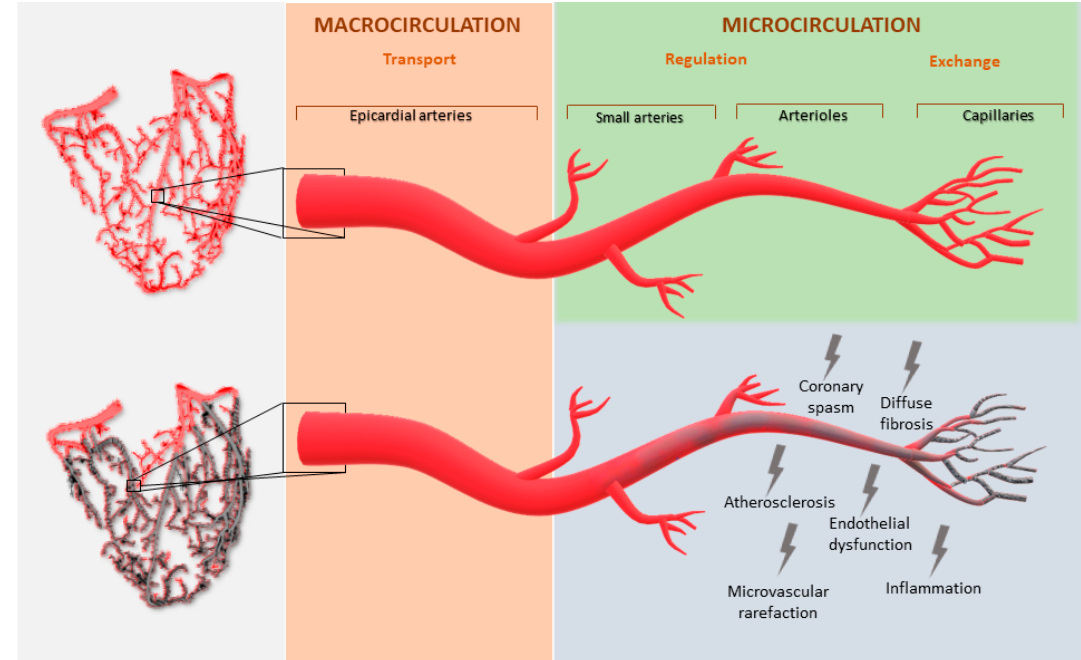
Figure 2. Mechanisms of microvascular dysfunction. Table 1. Three clinical scenarios of MVD and the suggested assessment